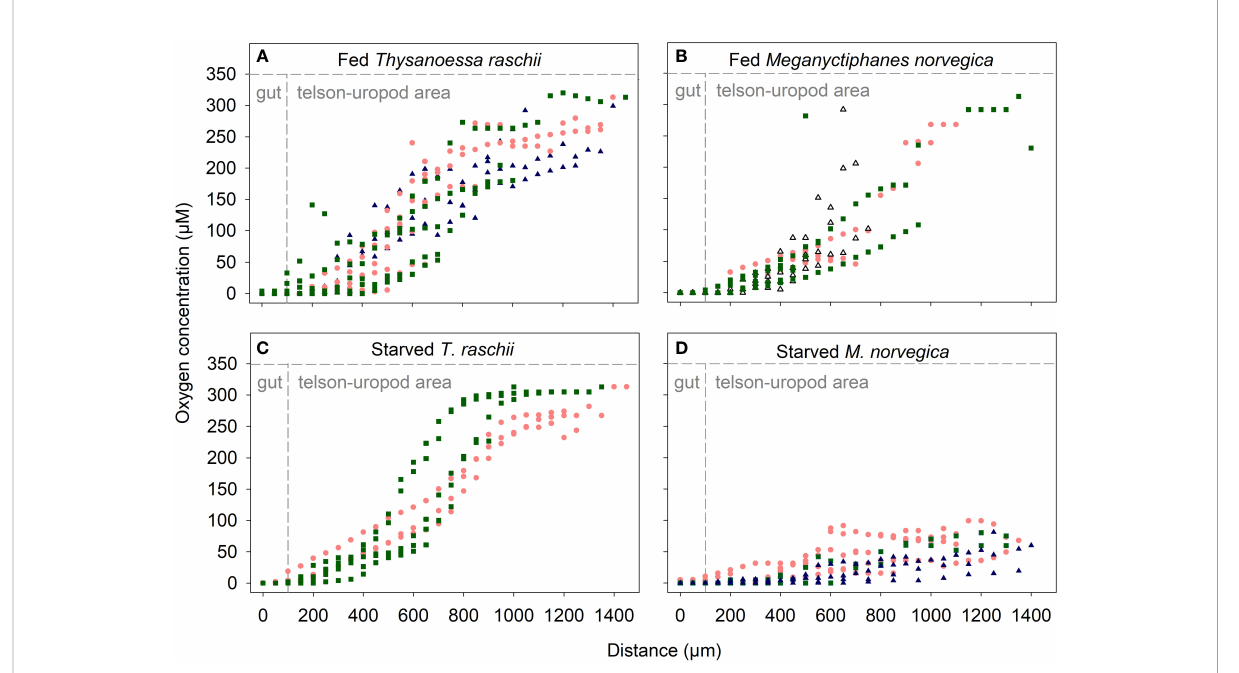
FIGURE 4 Oxygen micro pro fi les towards the guts of krill specimens with different feeding statuses. (A) Fed Thysanoessa raschii . (B) Fed Meganyctiphanes norvegica . (C) Starved T. raschii . (D) Starved M. norvegica . Each color/shape of the symbols corresponds to several micro pro fi les on the same individual. Triangles in panel B depict the micro pro fi les of one dead specimen. Panel sectors bordered by dashed lines depict different microenvironments where oxygen concentration was measured. Microsensors were moved from the area enclosed by the telson and uropods of krill towards the